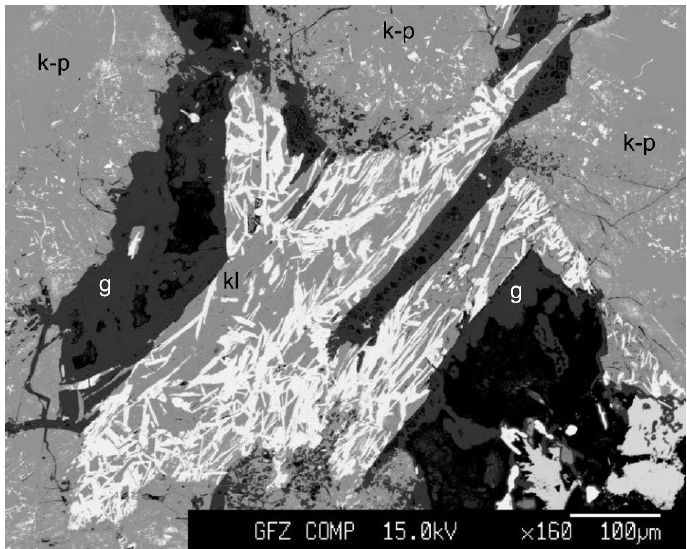
Figure 2. BSE image showing a pseudomorph composed of bright type-II cerromojonite, watkinsonite, and quijarroite, cemented by medium-grey klockmannite. Abbreviations: k–p = krut’aite–penroseite solid solutions, kl = klockmannite, g = goethite.